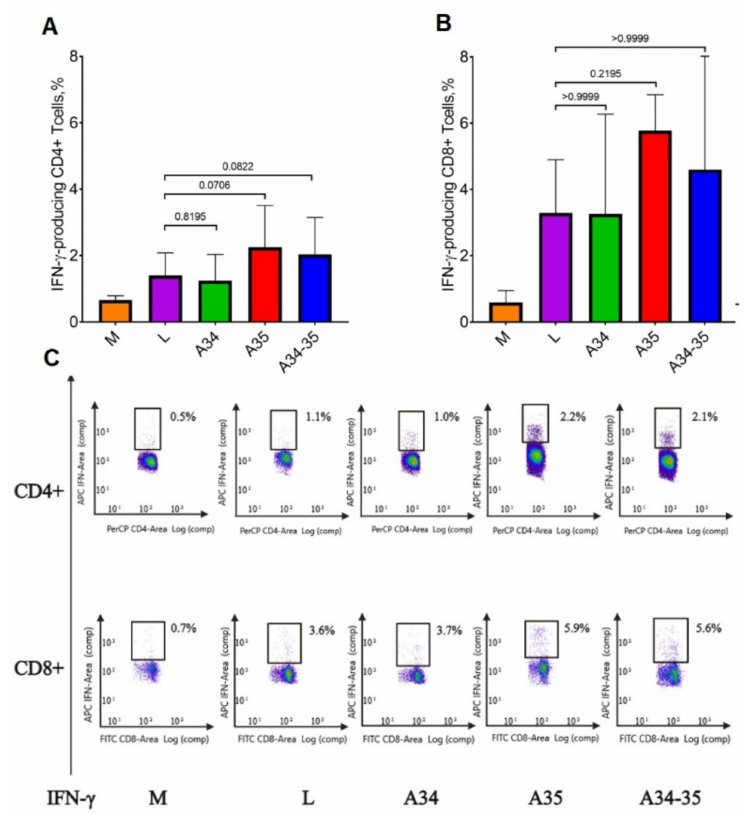
Figure 4. The results of analyzing the T cell-mediated response in immunized BALB/c mice using ICS and flow cytometry. M—control (non-immunized) mice; L—the VACV LIVP strain; A34—LIVP- A34R*; A35—LIVP-dA35R; and A34-35—LIVP-A34R*-dA35R. The percentages of virus-specific CD4+ ( A ) or CD8+ ( B ) T cells secreting IFN- γ in response to stimulation with a peptide pool from LIVP virus proteins are shown. The diagrams show the median values and the range. Statistical analysis was performed using the GraphPad Prism 9.0 software. Intergroup differences in immune responses were assessed with the non-parametric one-way Kruskal–Wallis analysis of variance adjusted for multiple comparisons used Dunn’s statistical hypothesis testing. The p values are indicated above the horizontal brackets. ( C ) The typical flow cytometry data plots (diagrams) for CD4+ and CD8+ T